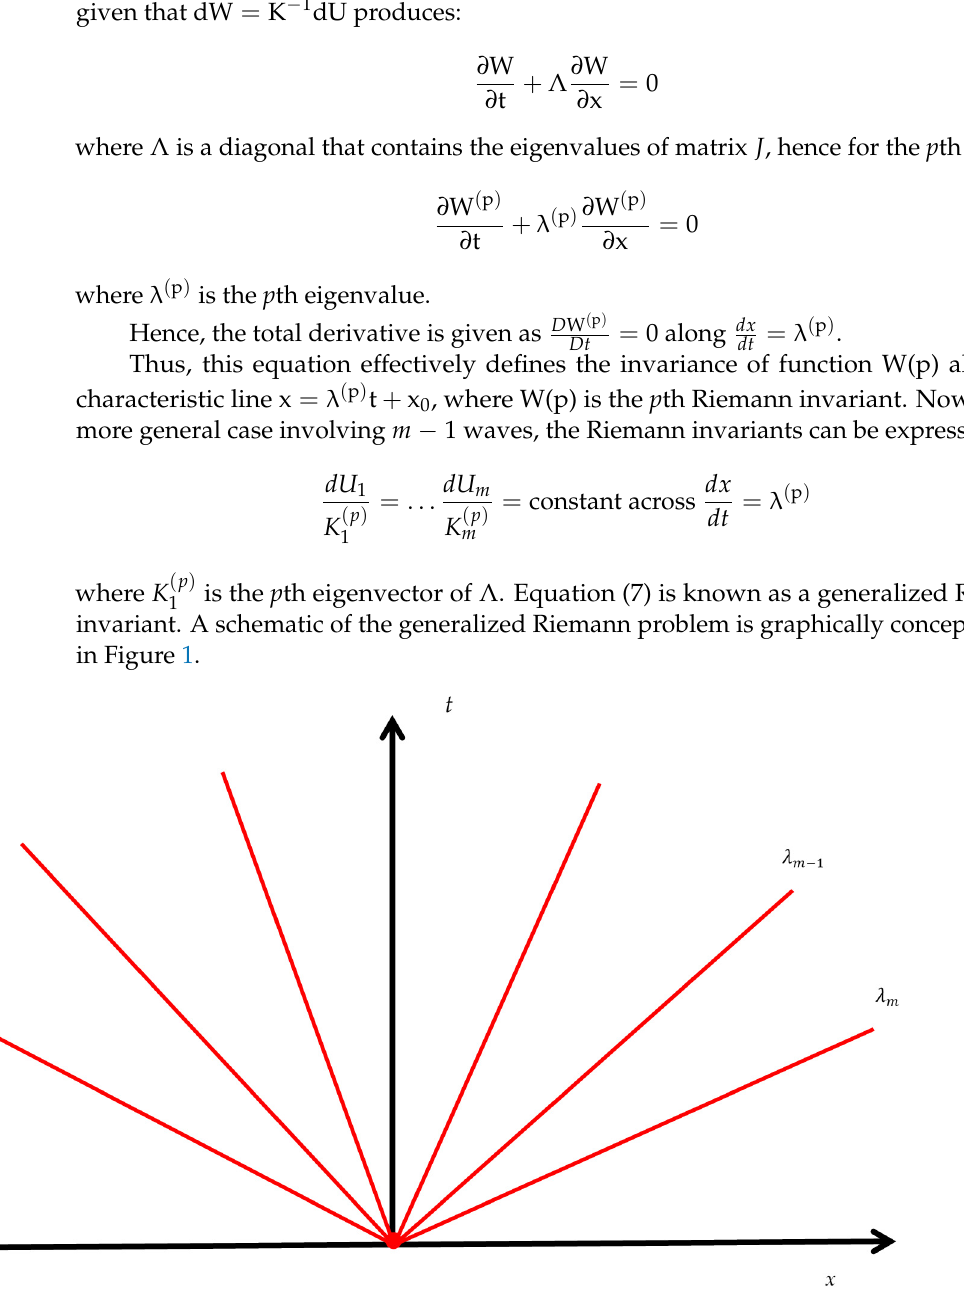
Figure 1. Generalized Riemann problem solution for an 𝑚 × 𝑚 linear hyperbolic system with a constant coefficient [1].